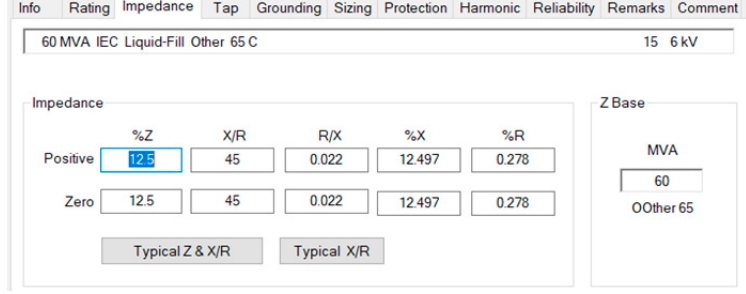
Figure 7. The nominal data for T5.